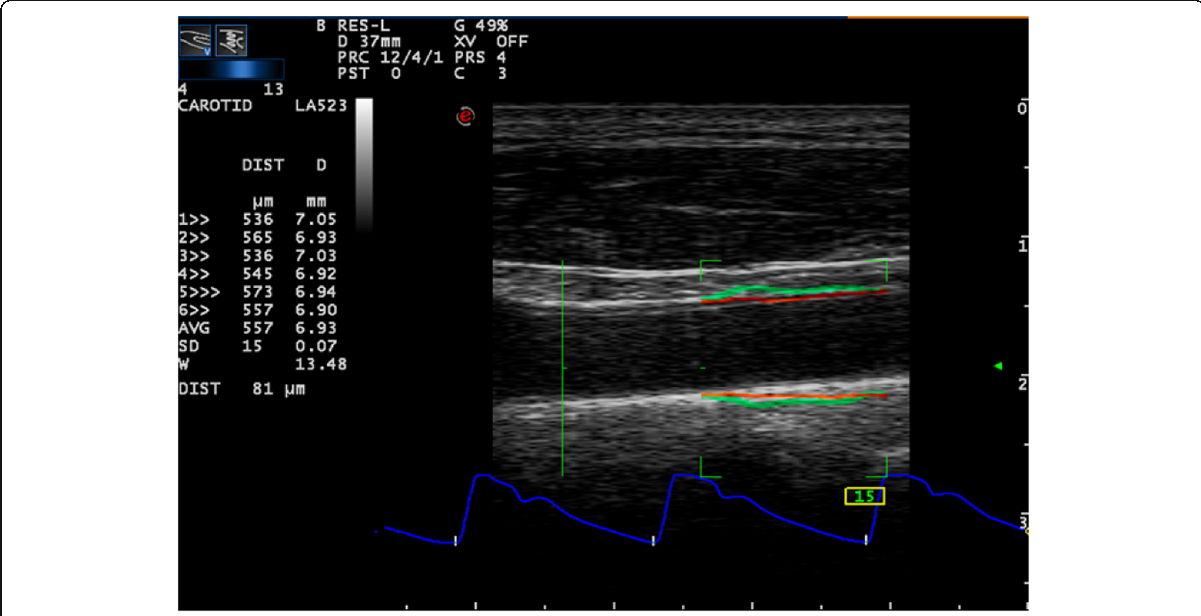
Fig. 1 Quality arterial stiffness — radiofrequency wall-tracking system. The movement of carotid walls is tracked in the entire region of interest (green rectangle) composed of 32 scanning lines. Continuous orange lines indicate the automatic positioning of wall-tracking points at media- adventitia interface. Continuous green lines display dynamically the amplified vessel wall movement (the real vessel wall movement is “ amplified ” by a predefined factor). Real-time distension waveforms are displayed at the bottom (blue line). The values of carotid distension (DIST) and minimum diameter (D) are displayed beat-to-beat on the screen, and the mean value (MED) over the last six beats and standard deviation (SD) are continuously calculated. This results in a frame rate of 500 Hz that allows the detection of wall velocity distension up to 36 mm/s. Diameter wall tracking: continuous orange lines without interruptions indicate a good